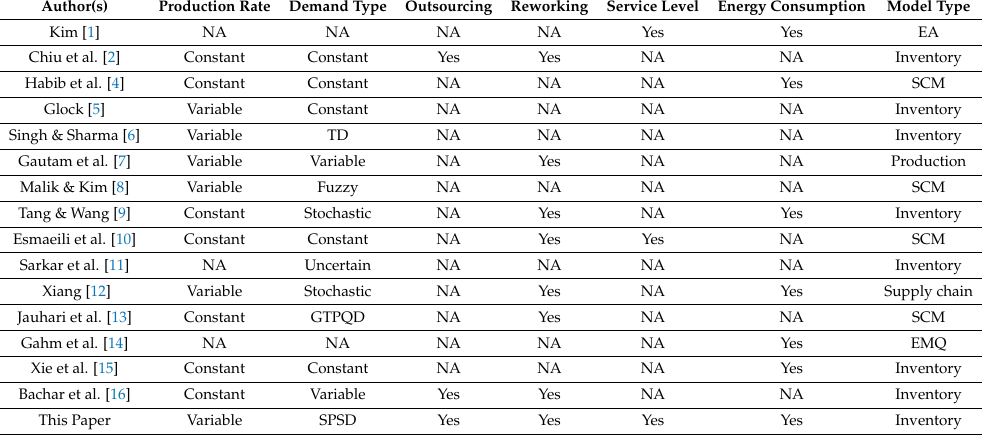
Table 1. Author(s) contribution